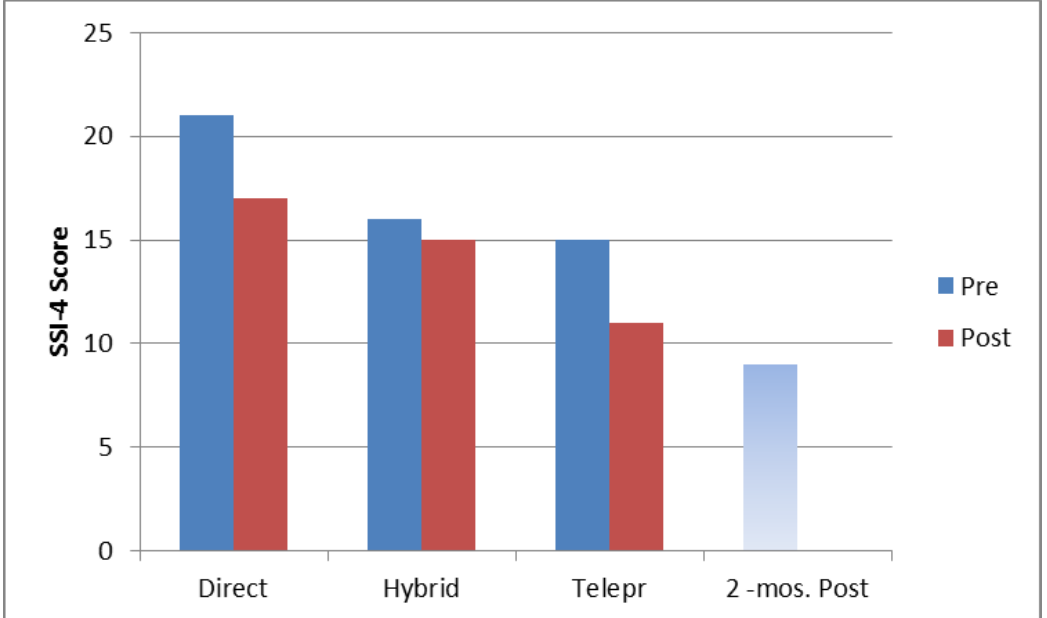
Figure 2. Participant 2 scores from Stuttering Severity Instrument-4 (SSI-4) across service delivery models (Telepr=